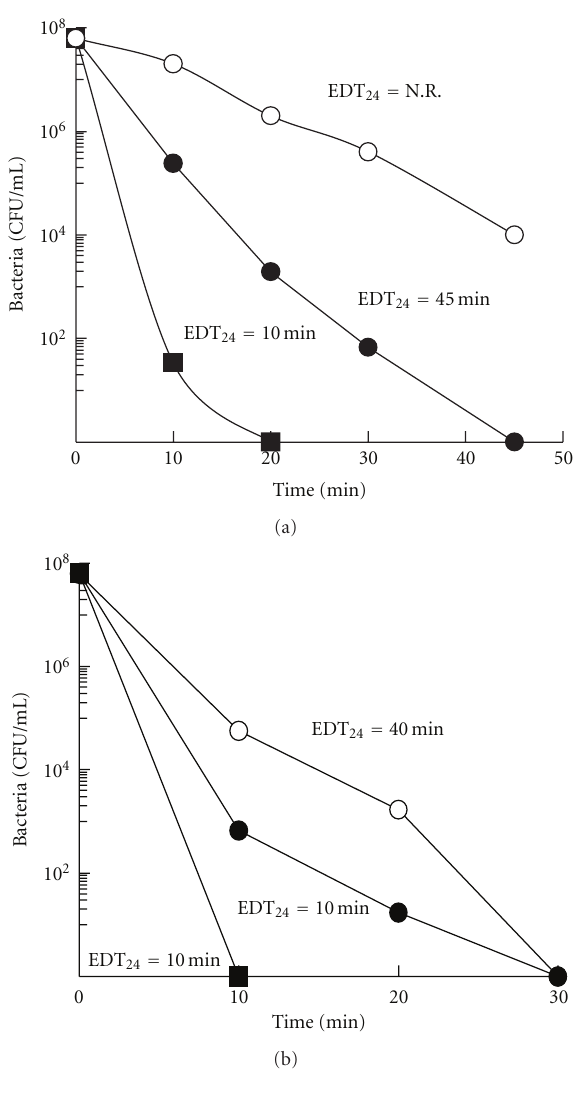
Figure 9: Photocatalytic water disinfection using: ( ( ) Ag(2)TiO 2 and ( (cid:4) ) TiO 2 samples, under (a) 250 and (b) (cid:0) 400W/m 2 of solar-simulated light